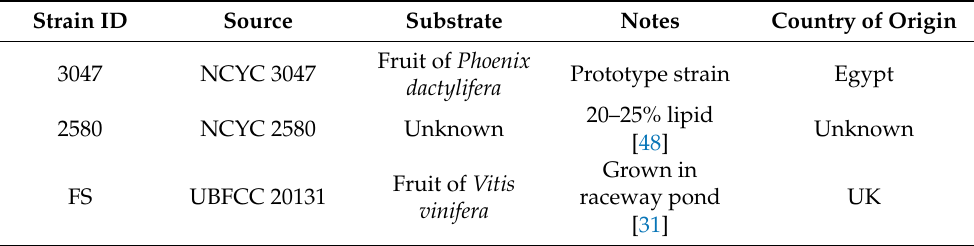
Table 1. Strains used for homologous